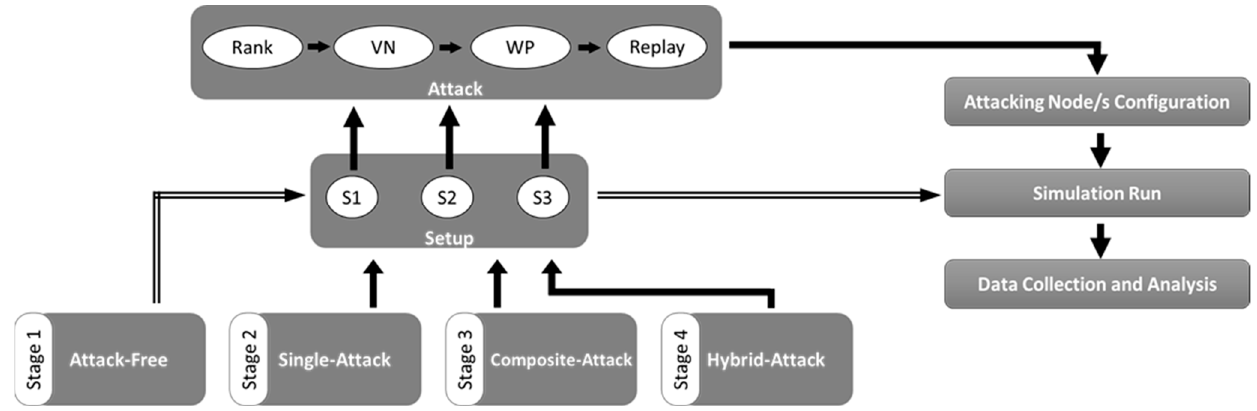
Figure 3. Overview of the Evaluation Methodology.